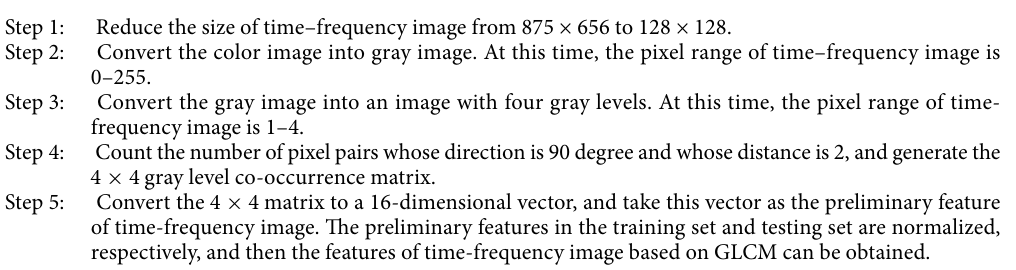
where x max and x min are the maximum and minimum values of each row before normalization, respectively, and y max and y min are the maximum and minimum values of each row after normalization, respectively. The specific steps of extracting the features of time-frequency image based on GLCM are as follows: